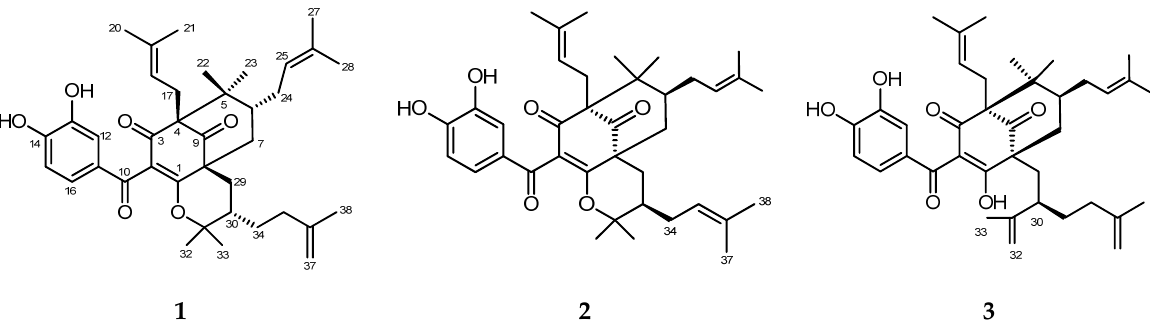
Figure 2. The structures of the polyprenylated benzophenones (compounds 1 – 3 ) isolated from the root bark of G. celebica .